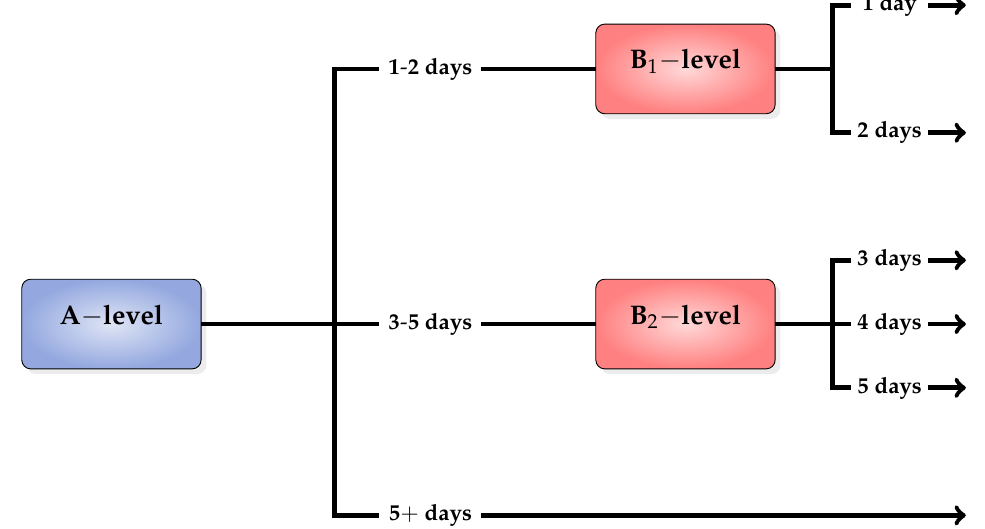
Figure 2. Two-level classification